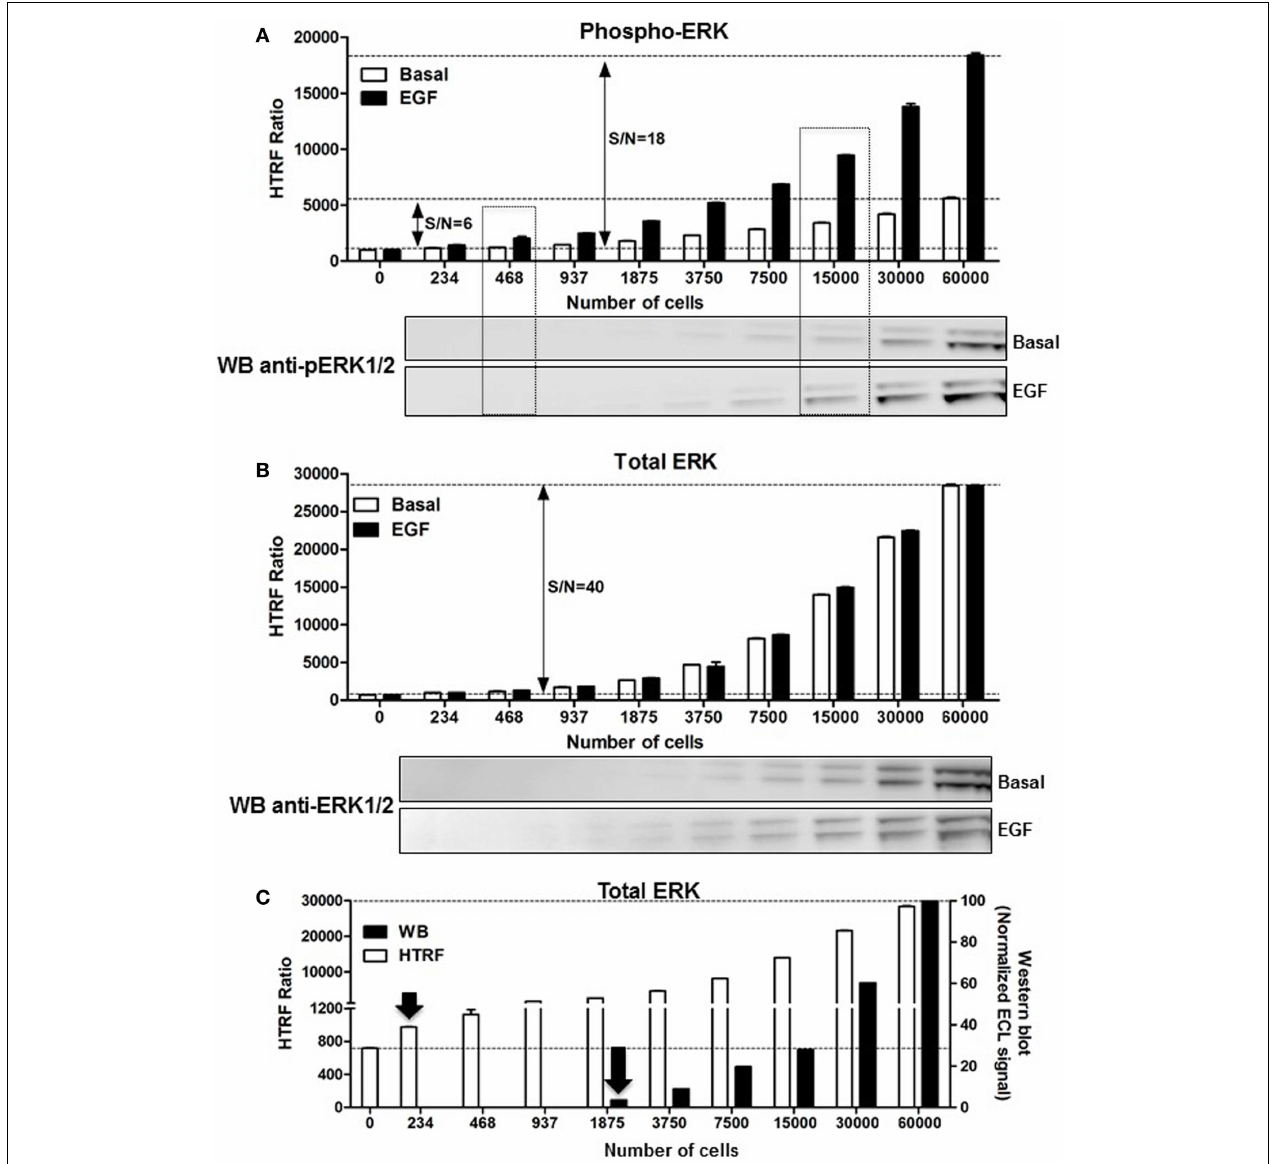
western blot [bottom of (A,B) ] as described in Section “Materials and Methods.” (C) The detection limit of the total ERK levels using the two methods was represented by plotting the total HTRF signals (HTRF) with the enhanced chemiluminescence (ECL) signal obtained by densitometry from the western blot (WB) normalized to the signal obtained with 60,000 cells/well as 100%.The data are mean ± SEM of three independent experiments performed in